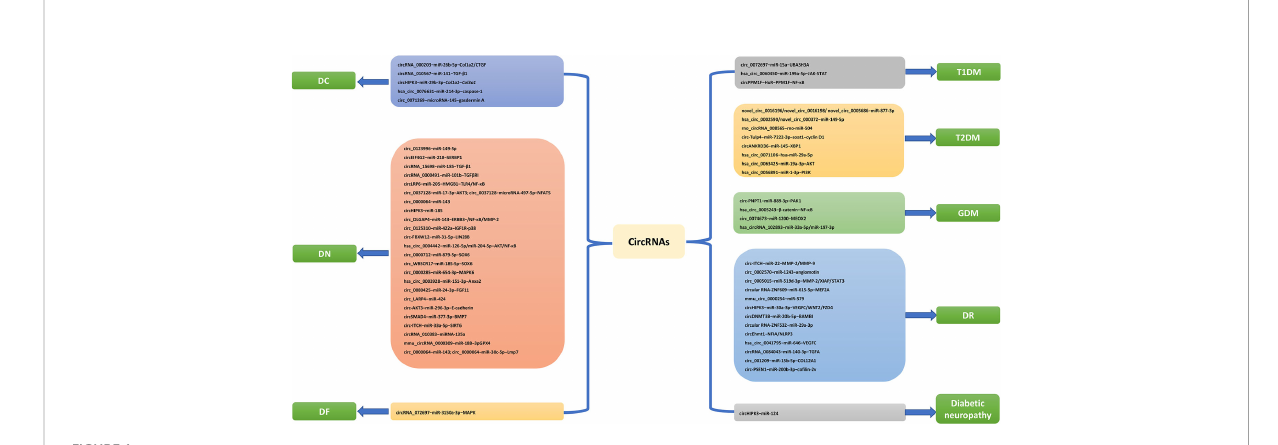
FIGURE 1 CircRNA pathways related to DM and its